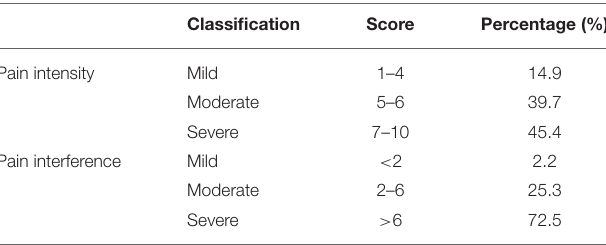
TABLE 1 | Distribution and classification of pain intensity and pain interference scores from the Brief Pain Index ( N = 949).